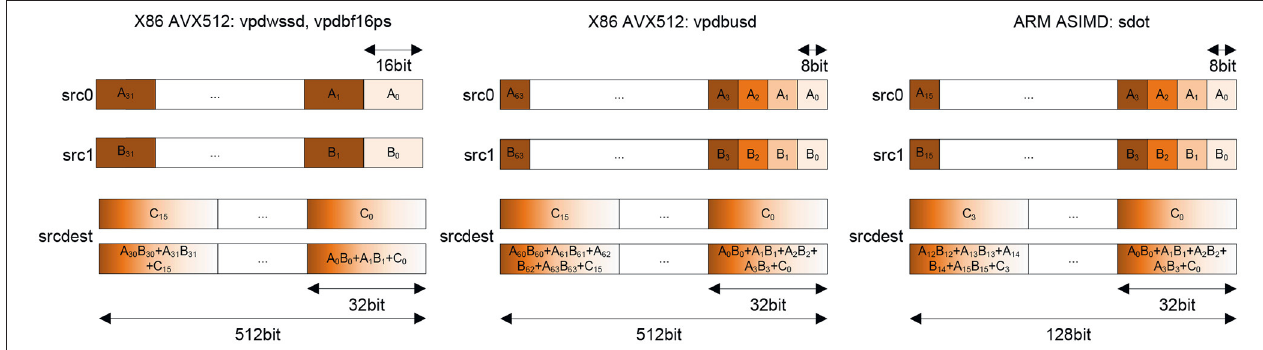
FIGURE 3 | Mixed-precision dot-product instructions, Left : 16bit integer and bfloat16 on Intel AVX512, Middle : 8bit integer using Intel AVX512, Right : 8bit integer using ARM ASIMD.